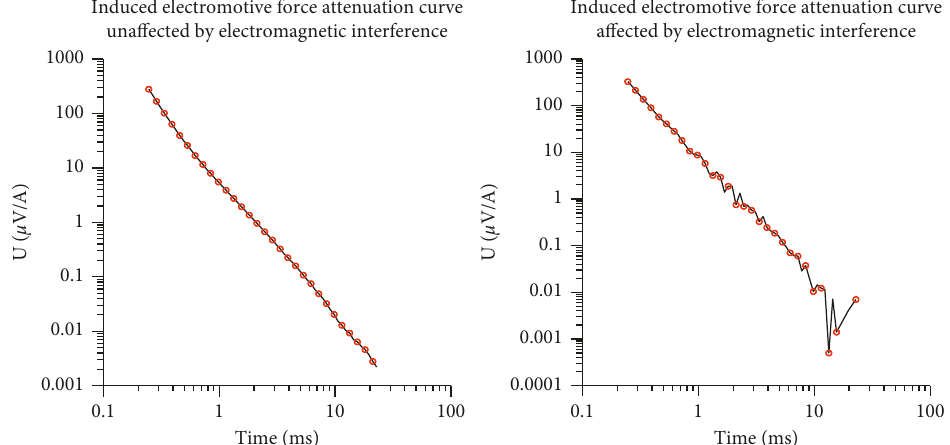
Figure 7: Comparison of single-point attenuation curves of transient electromagnetic